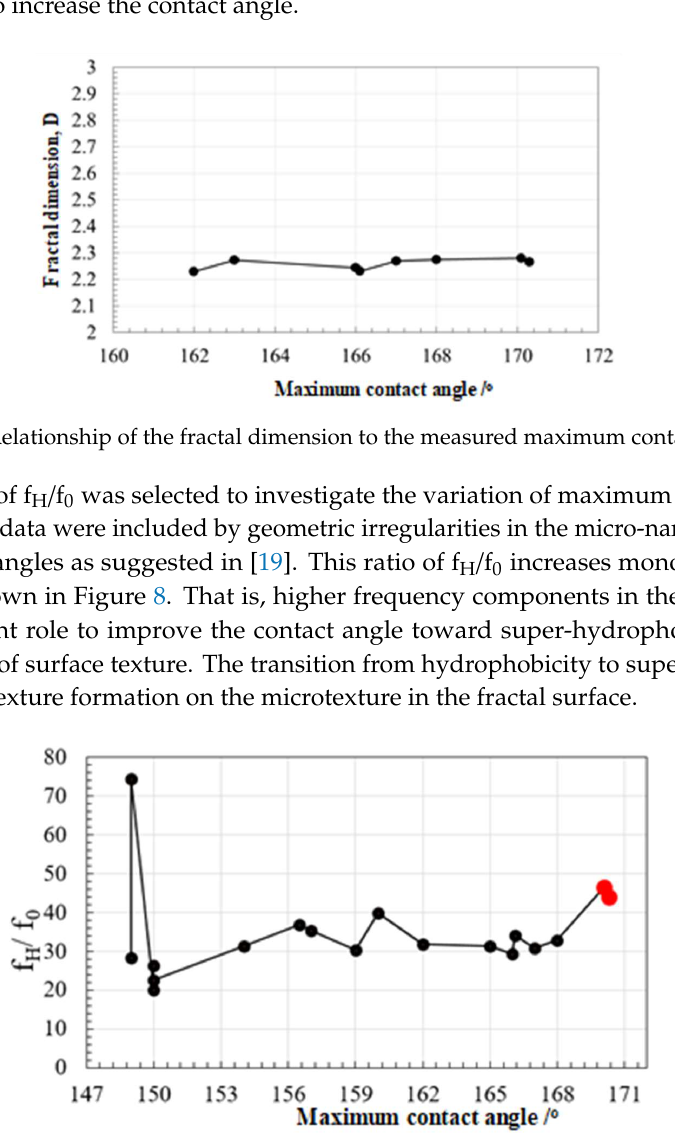
Figure 8. Relationship between the f H / f 0 ratio and the maximum static contact angle. The red dots represent the highest contact angles by synthesizing the multi-frequency textures in Figure 2.